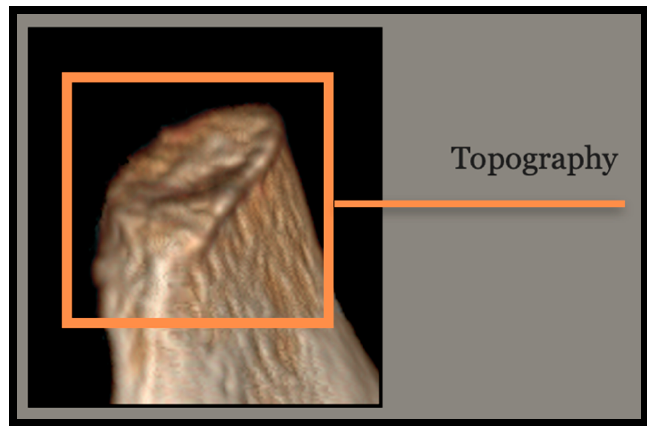
Figure 9. Guide to Surface Texture.